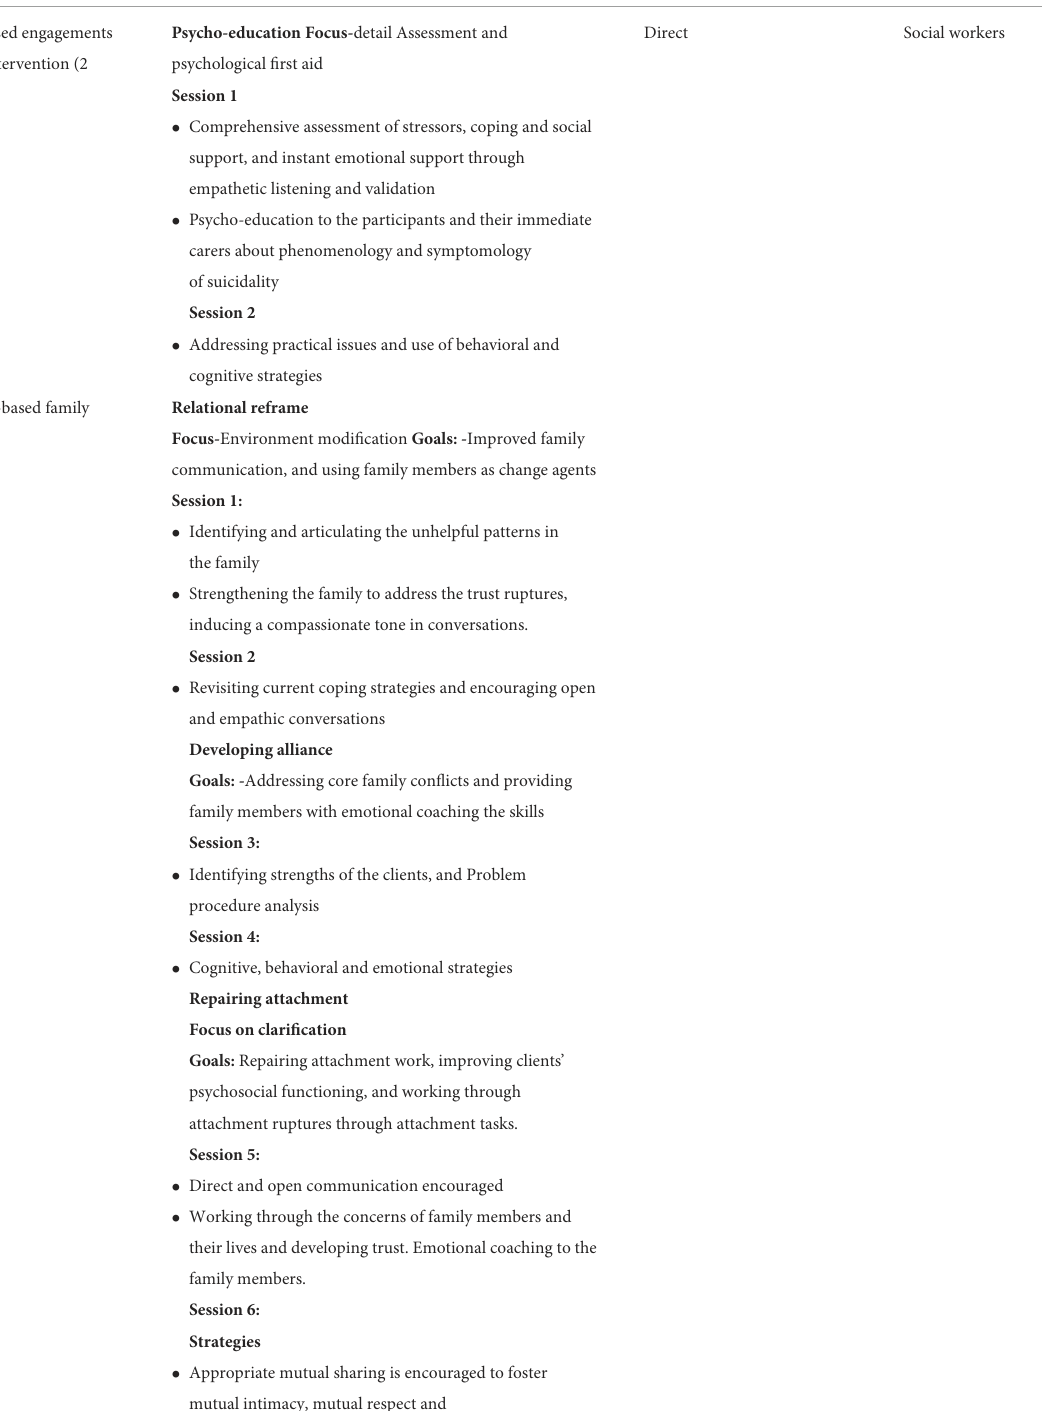
TABLE 2 Intervention components. Intervention Intervention components Delivery Human